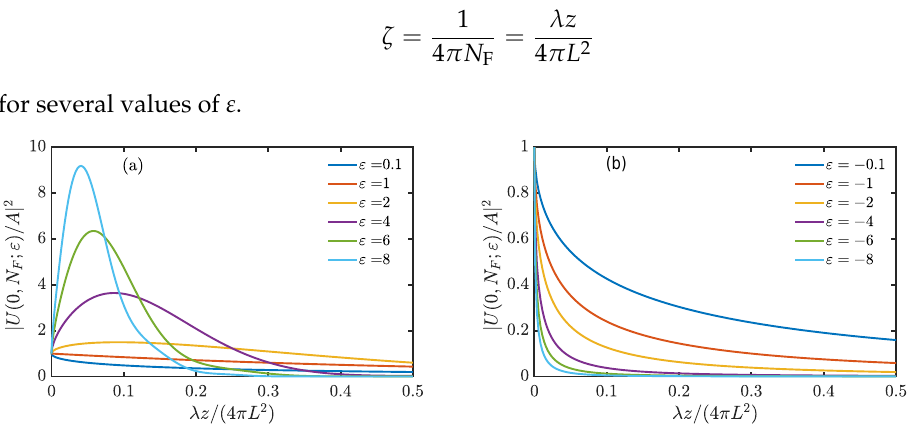
Figure 2. Axial intensity for ( a ) positive and ( b ) negative values of ε